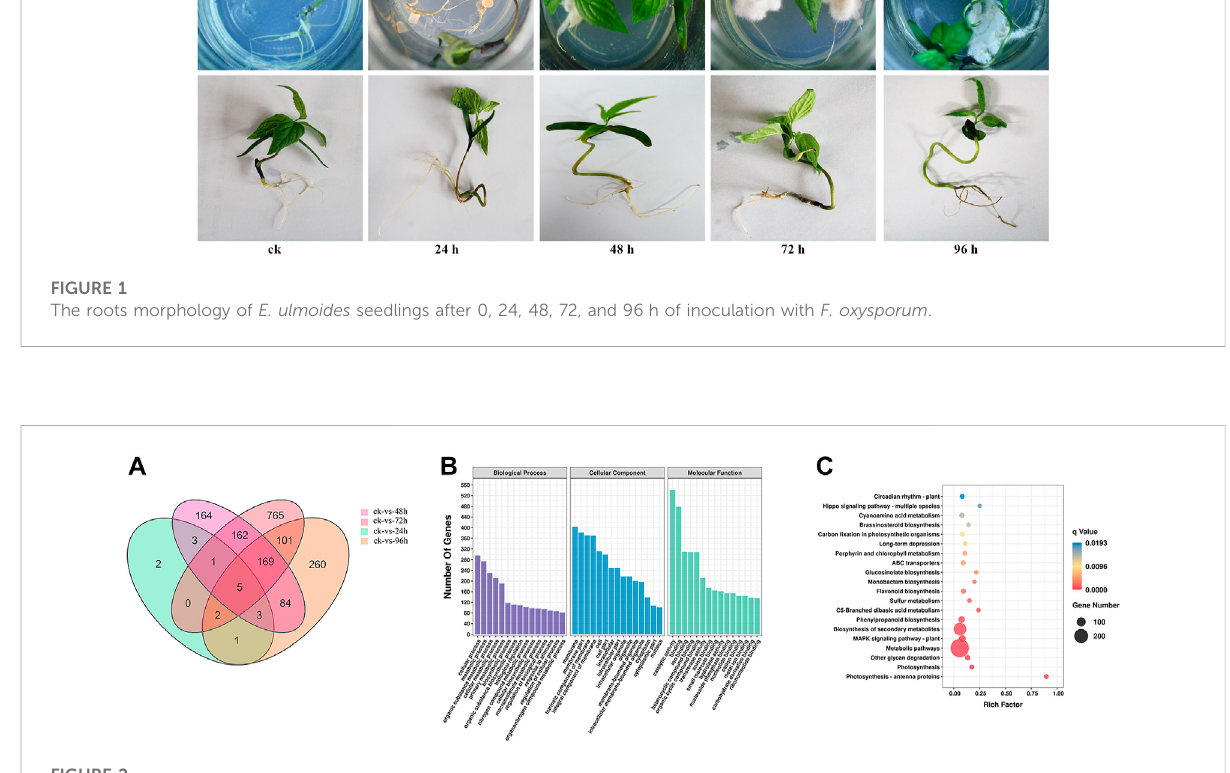
FIGURE 2 (A) Venn diagram of DEGs in E. ulmoides compared before (ck) with 24, 48, 72, and 96 h of inoculation with F. oxysporum , respectively. (B) GO analysis ofDEGs in E.ulmoides between0and 72 hofinoculationwith F.oxysporum . (C) KEGGenrichmentanalysis ofDEGs in E.ulmoides between 0 and 72 h of inoculation with F. oxysporum